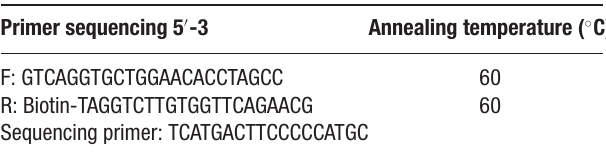
Table 1 . Primer sequences for genotyping of the − 1438 A/G polymor- phism by pyrosequencing.